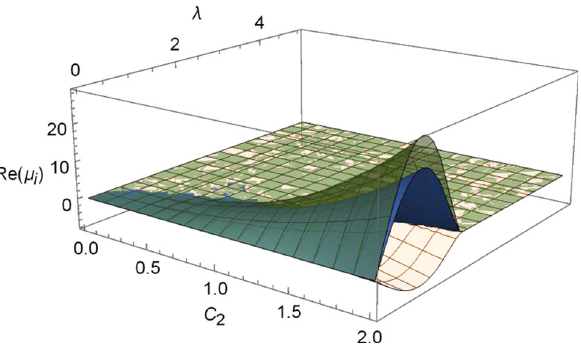
Fig. 10 Real parts of the μ i ’s associated to the equilibrium points ! , ± λ ) Q 7 , 8 : (Σ, A ,w) = 0 , 1 ) . The equilibrium points C 2 − λ 2 2 C 2 − λ 2 2 are typically saddles or non-hyperbolic with three zero eigenvalues, depending on the choice of parameters M 1 , 2 : ( A , v, u ) = ( 0 , 1 , ± 1 )